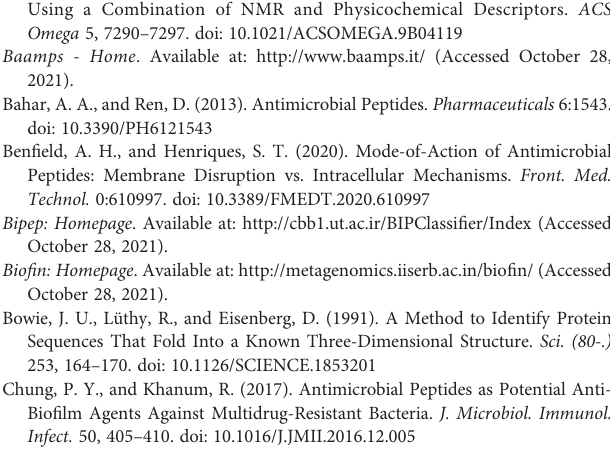
Supplementary Figure 3 | Visual representation of predicted interacting residues for 100 AMPs docked to the semi-open lid conformation of the C. striatum sortase C protein. AMPs were predicted to interact with the putative active site triad residues (except Cys230), protruding residues near the triad, as well as residues further away from the triad. Triad residues are colored purple, other interacting residues are colored forest green. Based on interacting residues and docking scores, AMPs were categorized into a preference score (10-0, highest to lowest) for further in silico , in vitro and in vivo